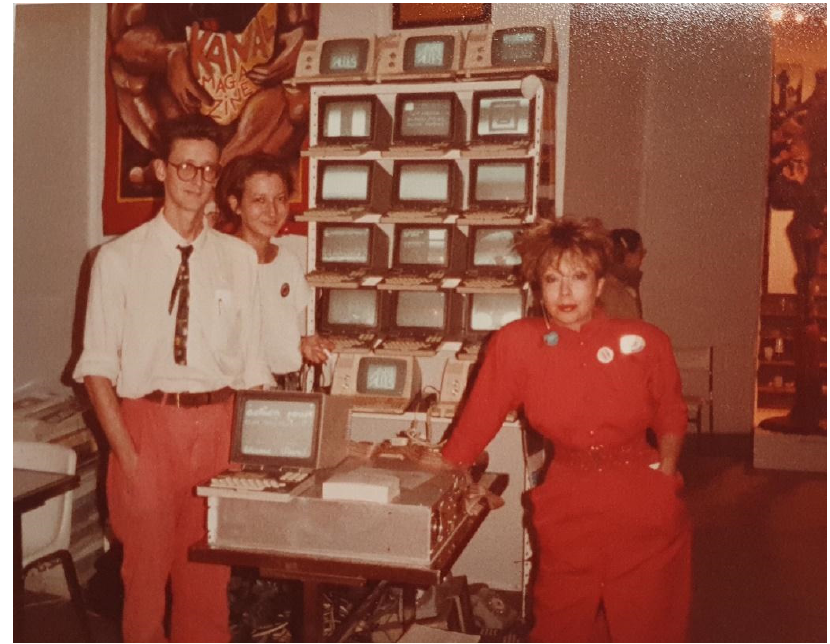
Figure 11. Installation of Art Accès at the 1985 FIAC with Frédéric Develay and ORLAN. Collection Frédéric Develay © Kandinsky Library, MNAM/CCI, Centre Pompidou.